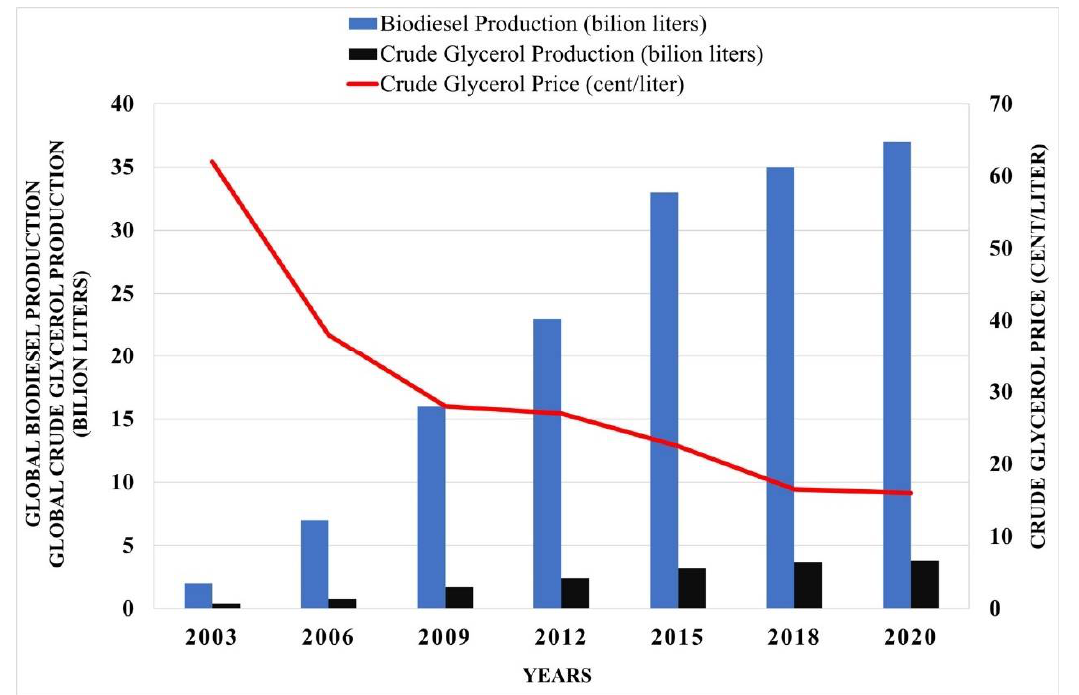
Figure 1. Global production of biodiesel and crude glycerol, and crude glycerol price between years 2003 to 2020. Data adopted from [11], open access journal of Green Chem. Lett. Rev.